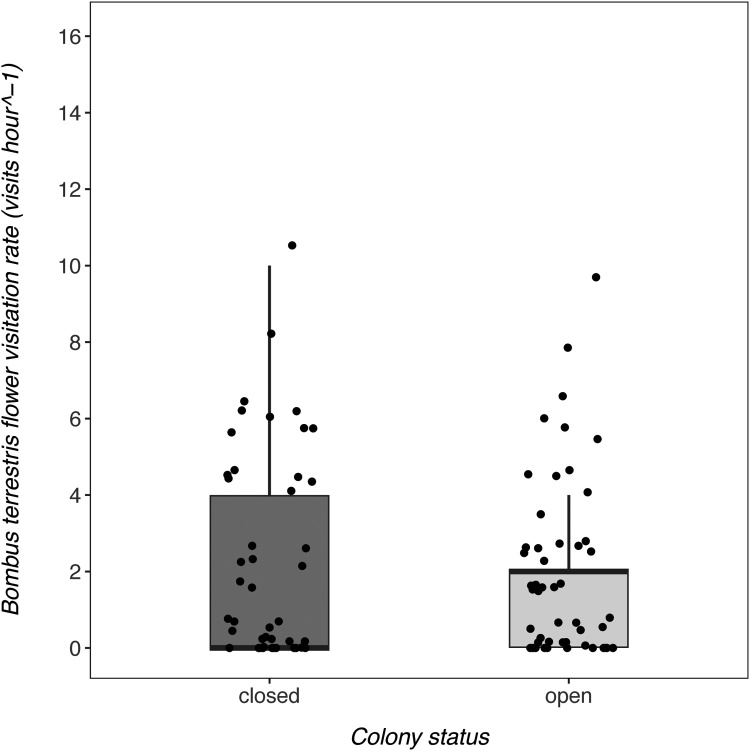
The flower visitation rate (visits hour−1) of B. terrestris audax on strawberry flowers in the everbearing crop. The median (central horizontal line), quartiles (box), non-outlier ranges (vertical lines) and raw data (dots) are presented on the plot.